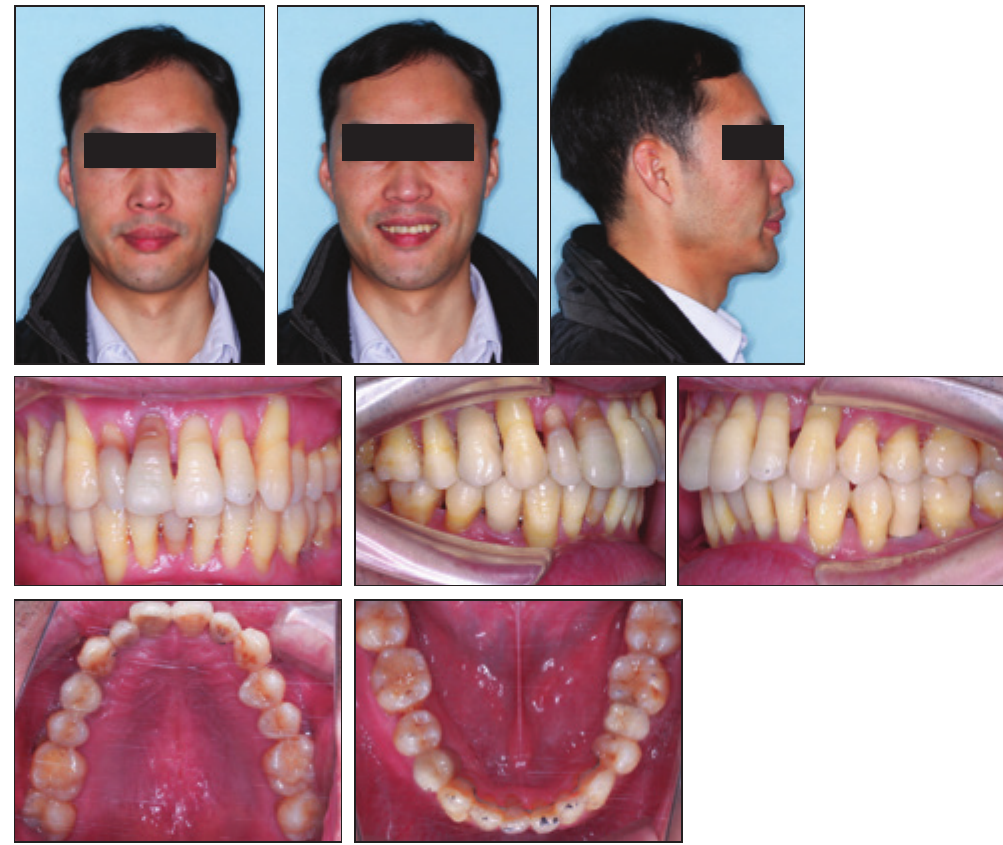
Figure 13. Three-year post-treatment facial and intraoral